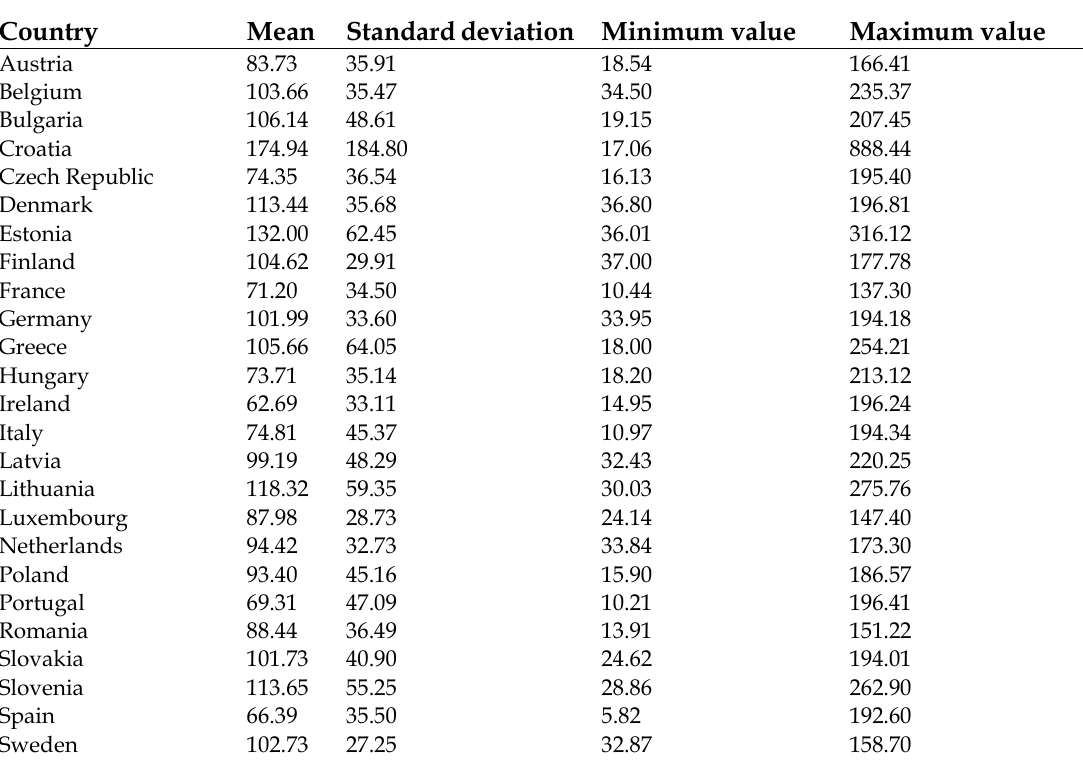
Table 3. Descriptive statistics for walking percentage changes from 15/02/20 to 15/02/21 (Sample size: